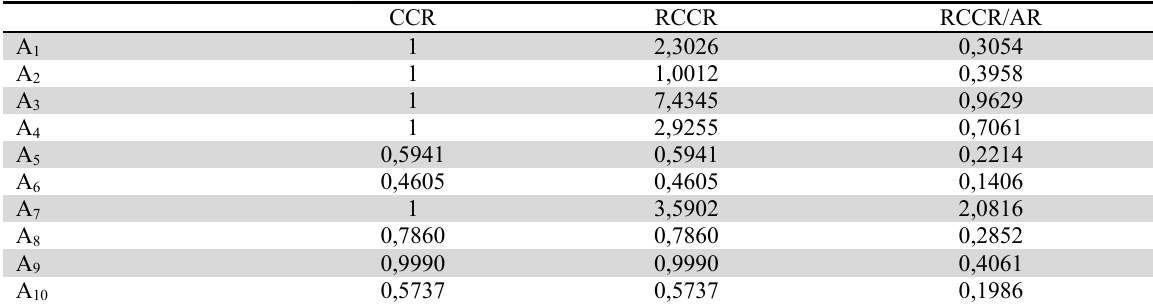
Final efficiency scores of TPL